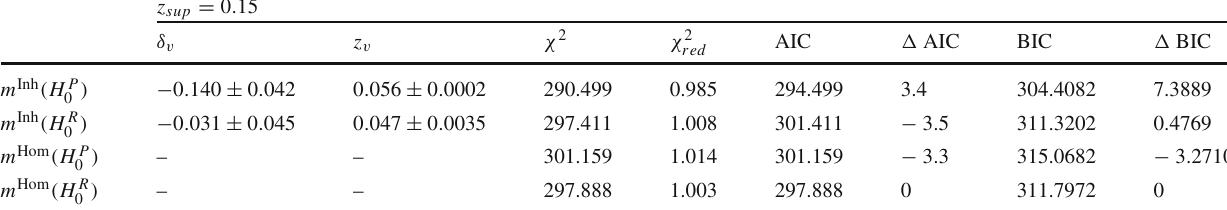
Table 1 Results of the fit of the Pantheon data. The inhomogeneous ibrated with the value of the absolute magnitude M P implied by H P models have two extra parameters, { z v ,δ v } , with respect to the homo- geneous models, which are taken into account in the calculation of χ 2 = χ 2 / d . o . f . and AIC . The (cid:7) AIC and (cid:7) BIC are defined with red ) . The inhomogeneous respect to the homogeneous model m Hom ( H R 0 ) is the best fit model, according to the χ 2 model m Inh ( H P , the AIC , red 0 ) is disfavored, in agreement with [27]. and the BIC , while m Inh ( H R 0 This shows that a small local inhomogeneity allows to fit well SNe cal-